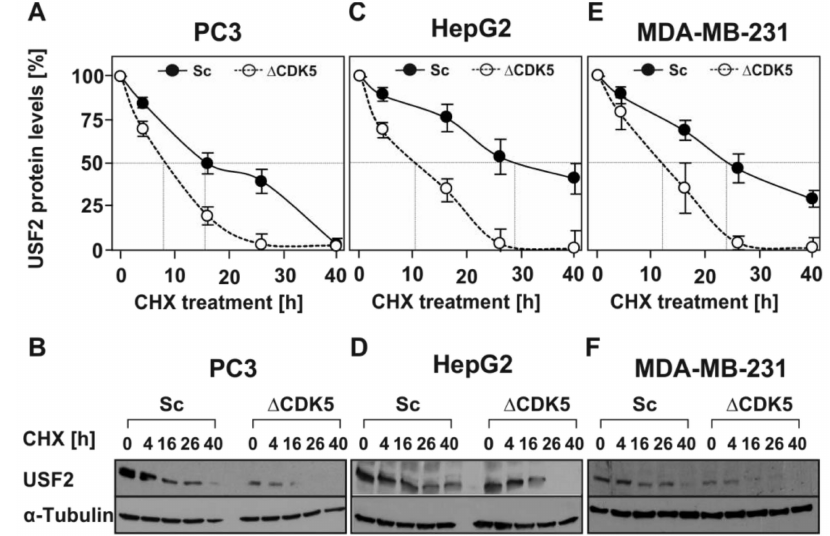
Figure 4. Absence of CDK5 reduces the half-life of USF2. ( A , C , E ) Respective Sc and ∆ CDK5 cells were treated with 10 µ g / mL CHX for the indicated time periods. Proteins were isolated, separated by SDS-PAGE and detected by western blotting. Protein levels were quantified and the relative protein level of USF2 was blotted against the duration of CHX treatment for estimation of the half-life. The dashed line indicates the USF2 half-life where 50% of the USF2 protein level was reached. ( B , D , F ) Representative western blots. 50 µ g of protein was probed with an antibody against USF2 and α